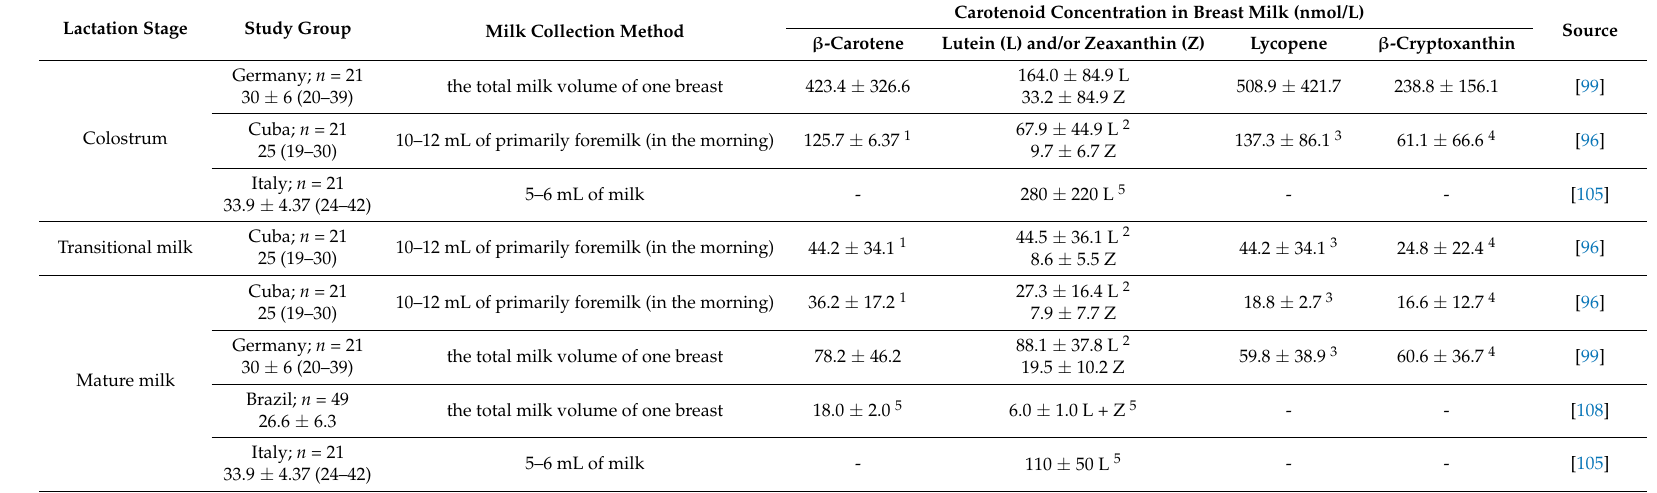
Table 2. The concentration of carotenoids in breast milk according to stage of